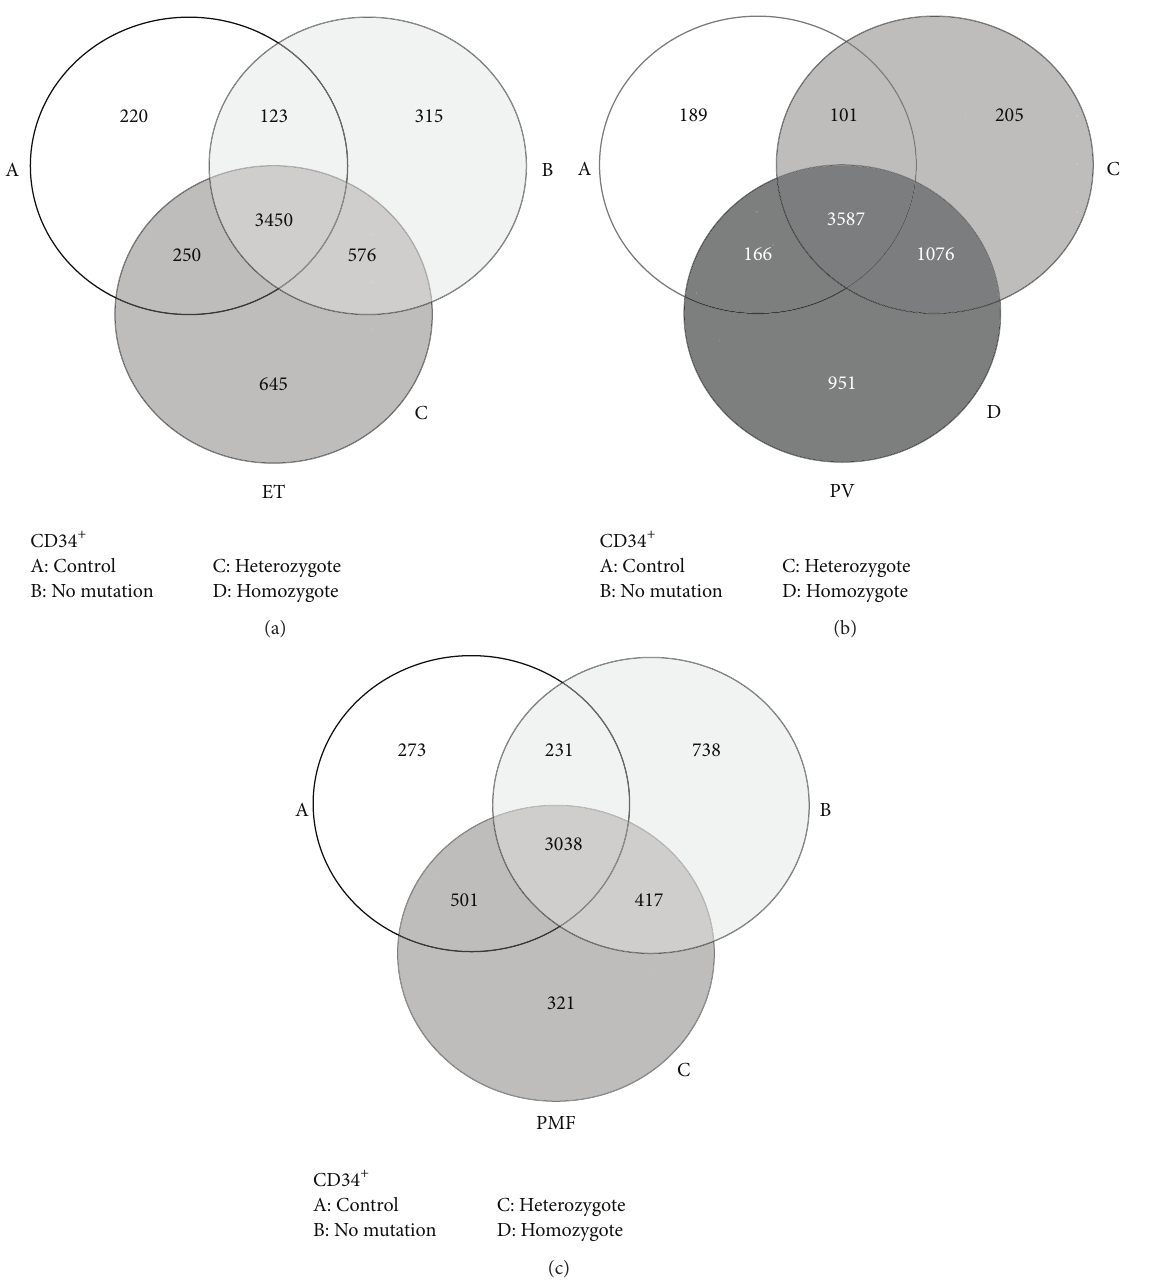
Figure 1: Microarray study of gene expression in CD34 + cells from peripheral blood of MPN patients. The Venn diagram shows similarity of total gene expression in controls ( 𝑛 = 8 ) and (a) JAK2 V617F heterozygous and no mutation ET forms ( 𝑛 = 9 ), (b) JAK2 V617F heterozygous and homozygous PV forms ( 𝑛 = 7 ), and (c) JAK2 V617F heterozygous and no mutation PMF forms ( 𝑛 = 4